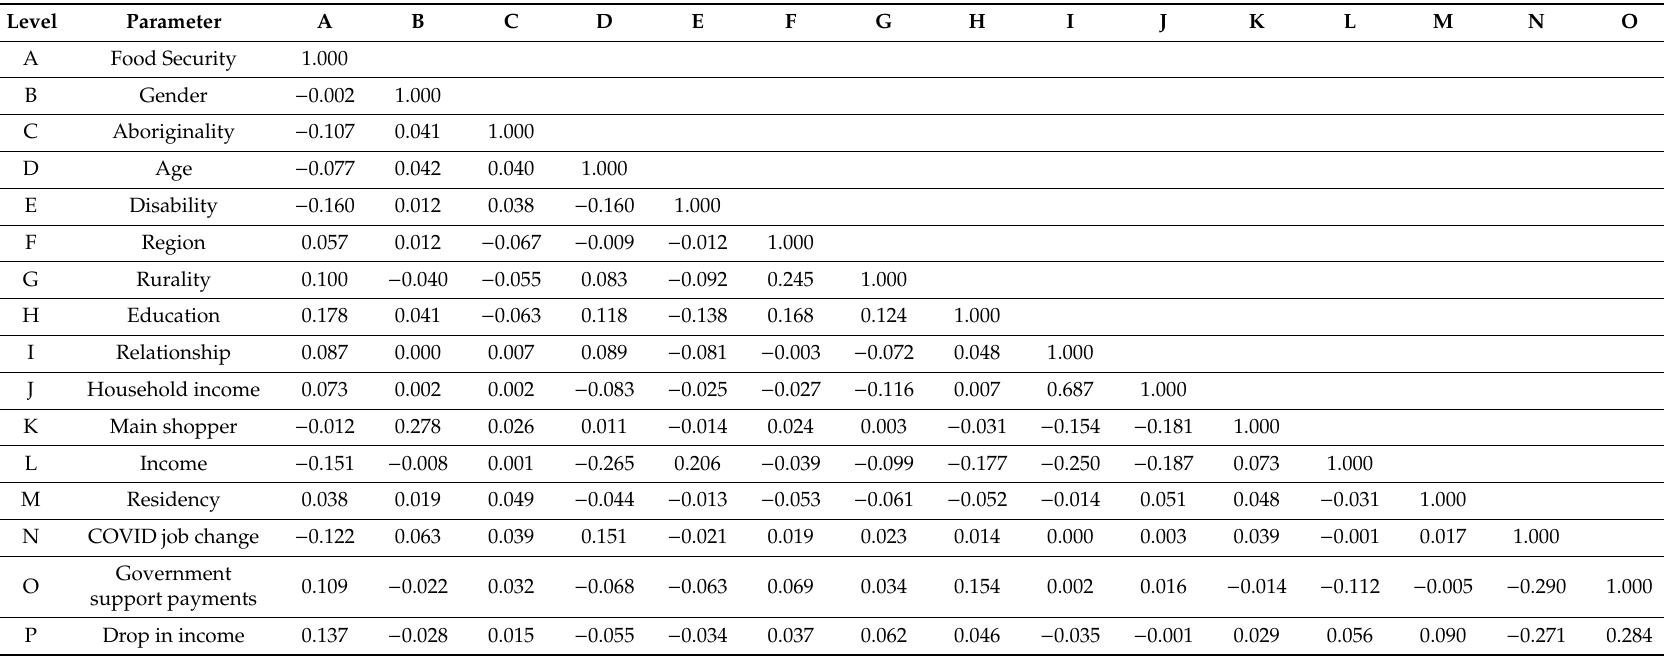
Table 4. Correlation matrix between socio-demographic variables and Food insecurity